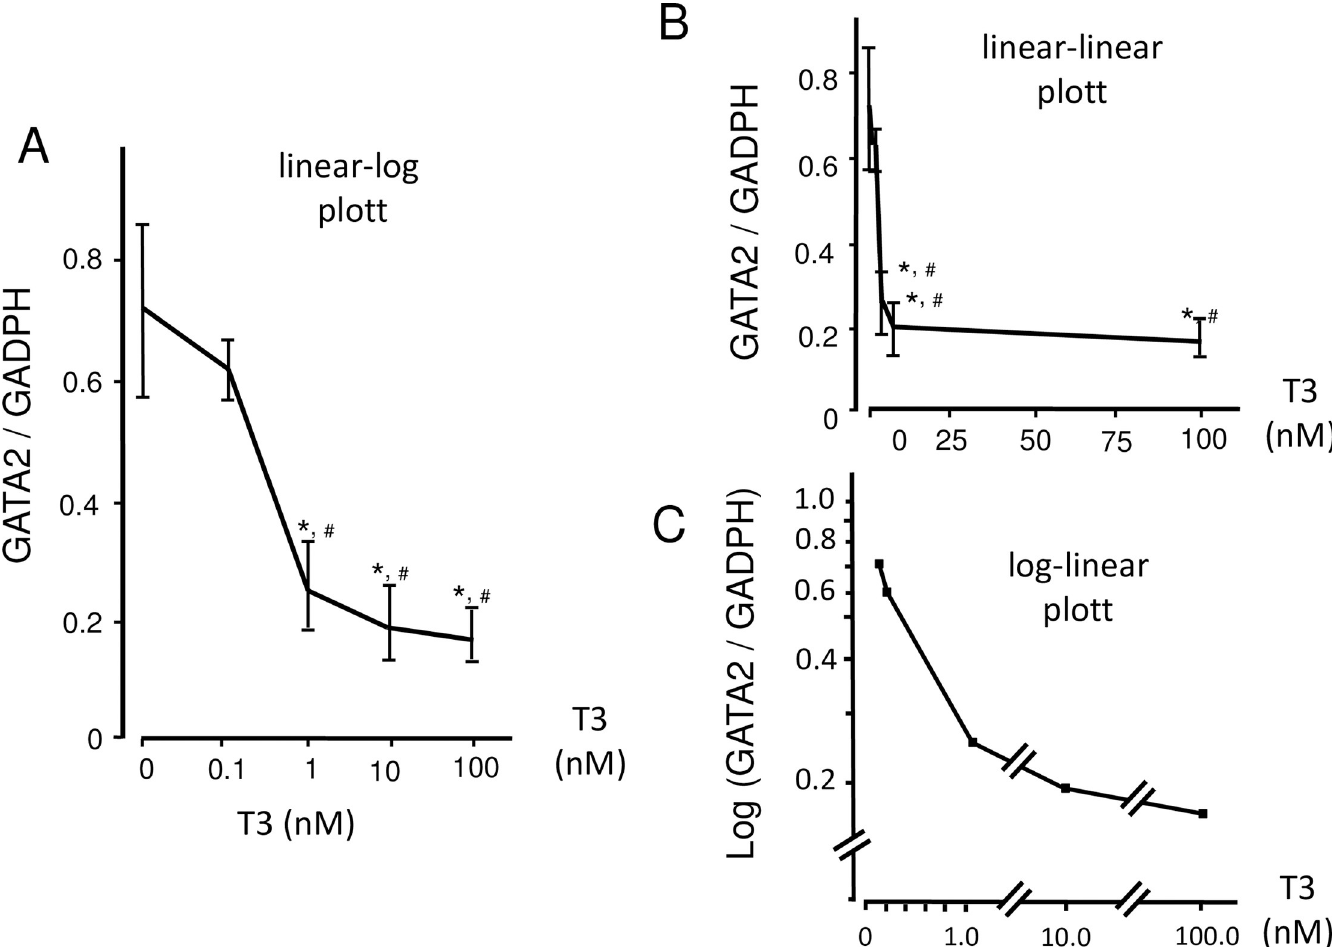
Fig 6. Inhibition of GATA2 mRNA by T3 in L β T2 cells. (A) Using RT-qPCR with primers specific for exon 1G and exon 2, the effect of T3 on the expression of GATA2 mRNA in L β T2 cells was evaluated. The shape of this graph was a negative sigmoidal curve. (B) The same data as in (A) are plotted with both [T3] (x-axis) and the GATA2/GAPDH ratio (y-axis) plotted in a linear scale. � , P < 0.01 vs. T3(-). #, P < 0.01 vs. T3 = 0.1 nM. (C) The same data as in (A) and (B) with the GATA2/ GAPDH ratio (y-axis) in a log scale and [T3] (x-axis) between 0–1.0 nM in a linear scale, which corresponds to moderate hypothyroidism and euthyroidism [57].